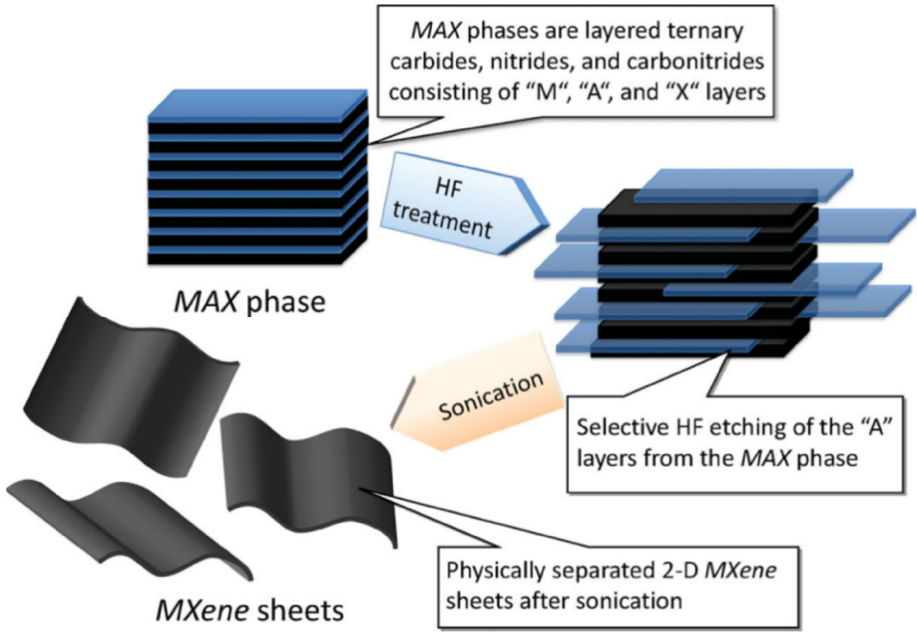
Figure 2. Schematic process of etching and exfoliation process of MXene from MAS phase. Repro- duced with permission from [35] Copyright (2012) American Chemical Society .